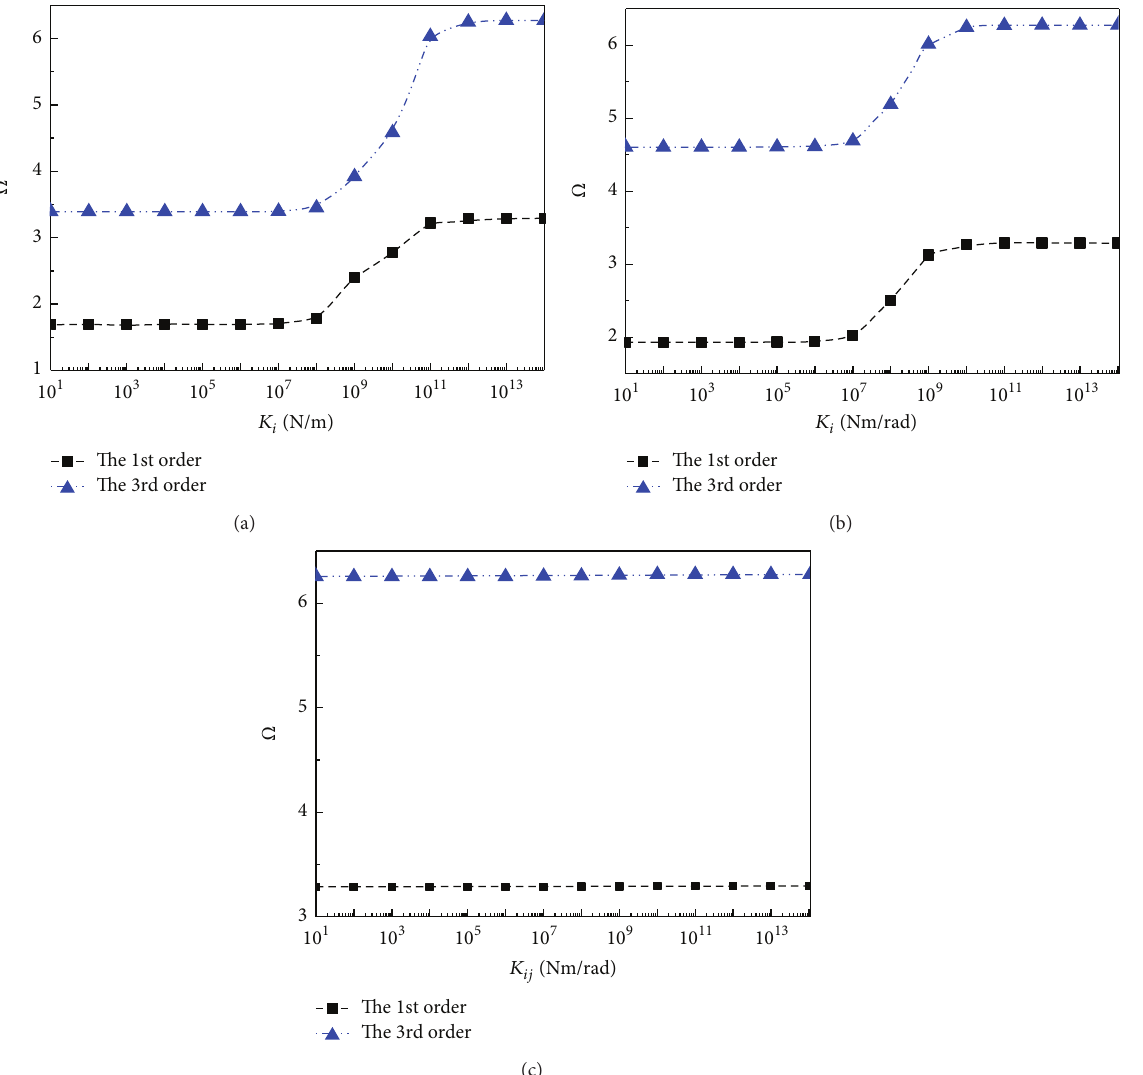
Figure 2: The effect of boundary spring stiffness on the natural frequencies Ω : (a) translation spring, (b) rotation spring, and (c) torsional